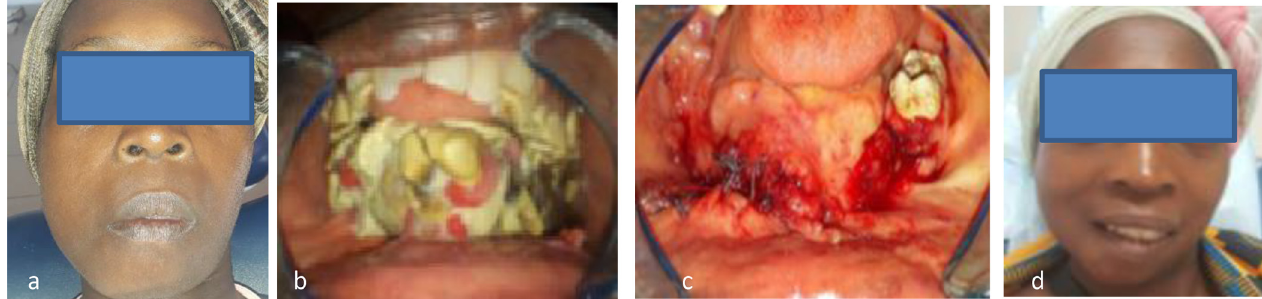
Fig. 4. Simple ablation of bulky sequestra (pulled out) and prosthetic rehabilitation. Right facial asymmetry (a). Intraoral view of the sequestrum (b) and after sequestrectomy (c). Prosthesis in place